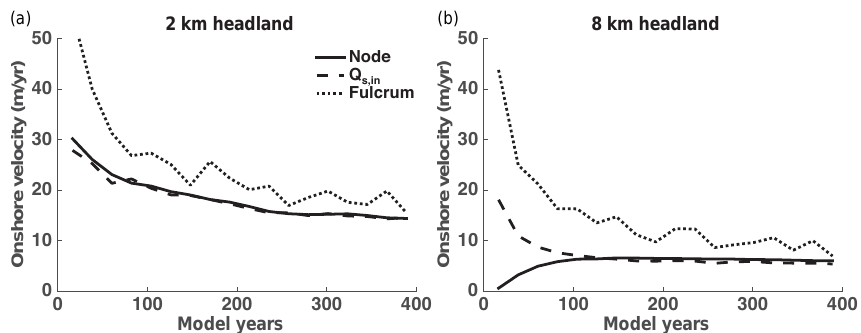
Figure 9. Rates of onshore migration of key spit locations over time for headlands of initial width of (a) 2km and (b) 8km, both experiencing symmetric wave climates ( A = 0 . 5, U = 0 .